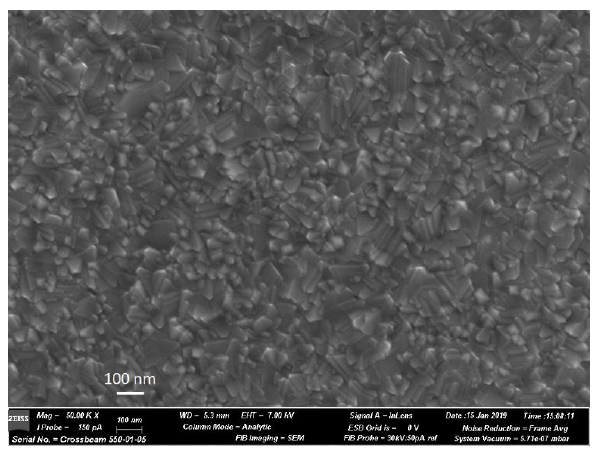
Figure 12. SEM image of the surface of Mo–Ti bilayer films heated at 800 °C and exposed to (Ar-31%N 2 -6%H 2 ) plasma for 1 h 30 min.